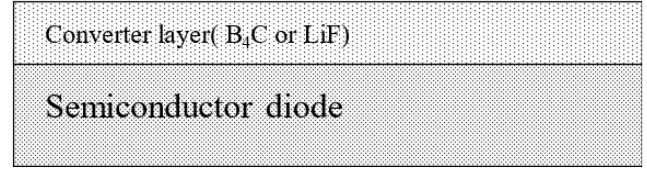
Figure 1. Schematic structure of the simulated